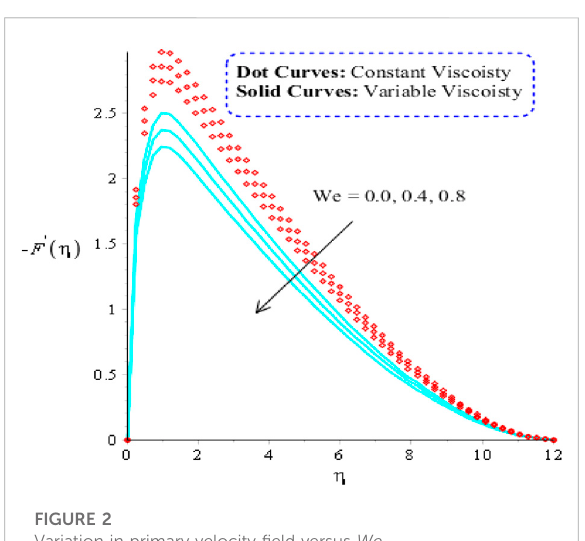
FIGURE 2 Variation in primary velocity fi eld versus We